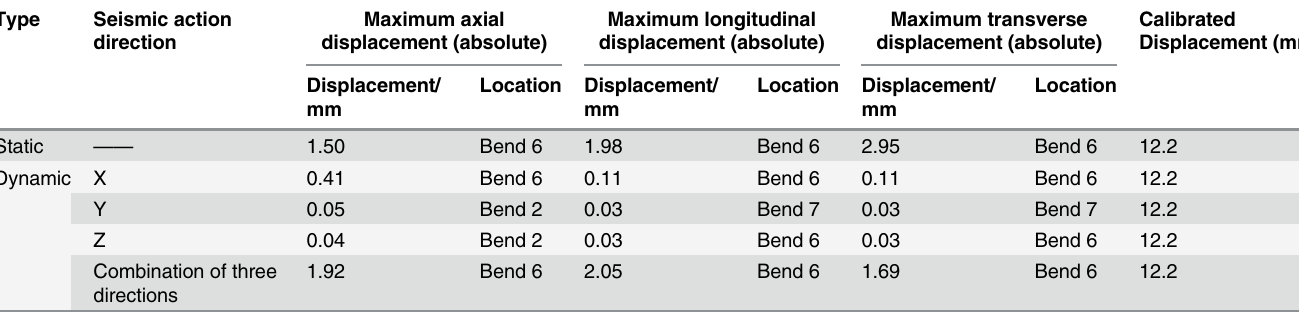
Table 9. Displacement calibration of pipeline under static and dynamic working conditions.